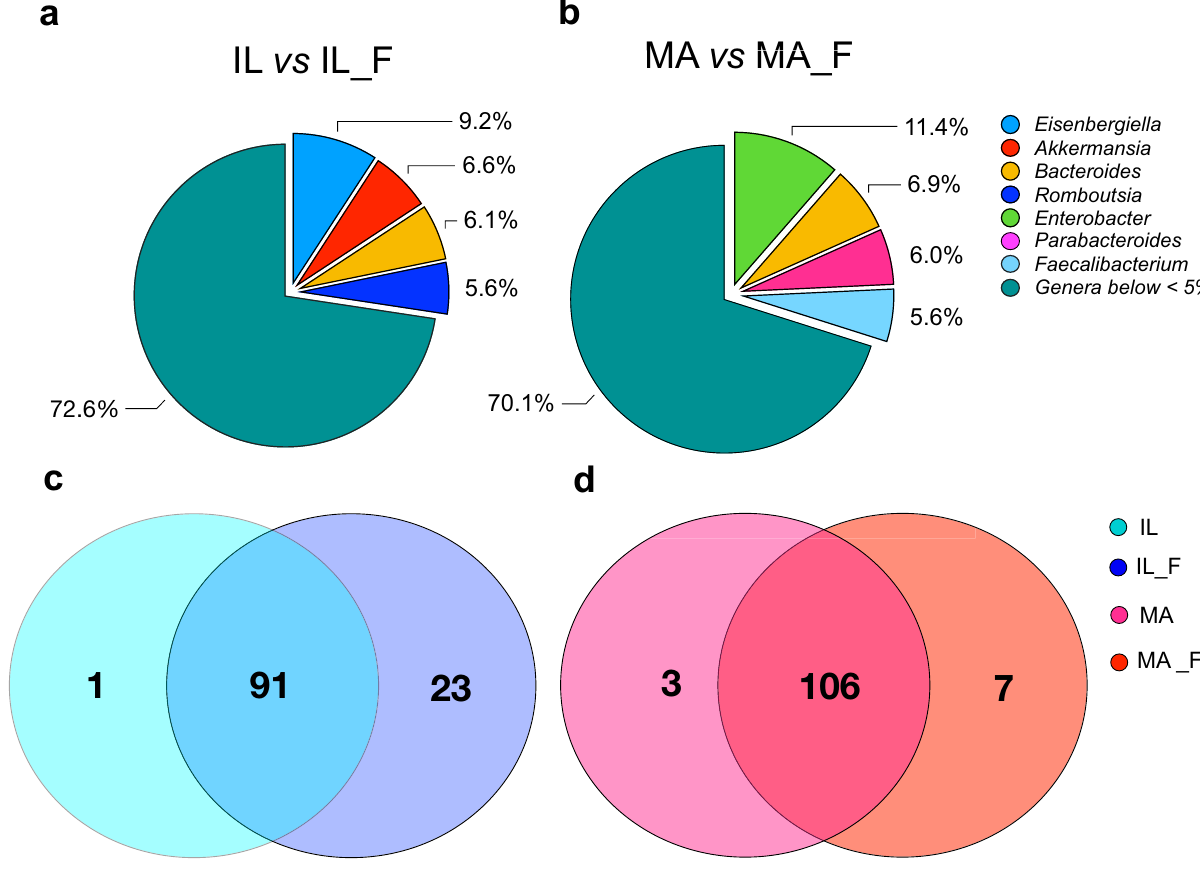
Figure 4. Relative contribution and exclusiveness of bacterial genera in the gut microbiota communities. Contribution of bacterial genera to differences among the gut microbiota of ( a ) IL (island lizard) vs IL_F (fed island lizard), and ( b ) MA (mainland lizard) vs MA_F (fed mainland lizard), calculated using SIMPER (Similarity Percentages Species Contributions). See Supplementary Table S8 and Supplementary Table S9 online for details. Symmetric Venn diagram of shared and unique bacterial genera in the gut microbiota of ( c ) IL (island lizard) vs IL_F (fed island lizard) and ( d ) MA (mainland lizard) vs MA_F (fed mainland lizard) groups, produced by Venn Diagram Tool freely available on the web (https:// bioin forma tics. psb. ugent. be/ webto ols/ Venn/). See Supplementary Table S10 and Supplementary Table S11 online for details.